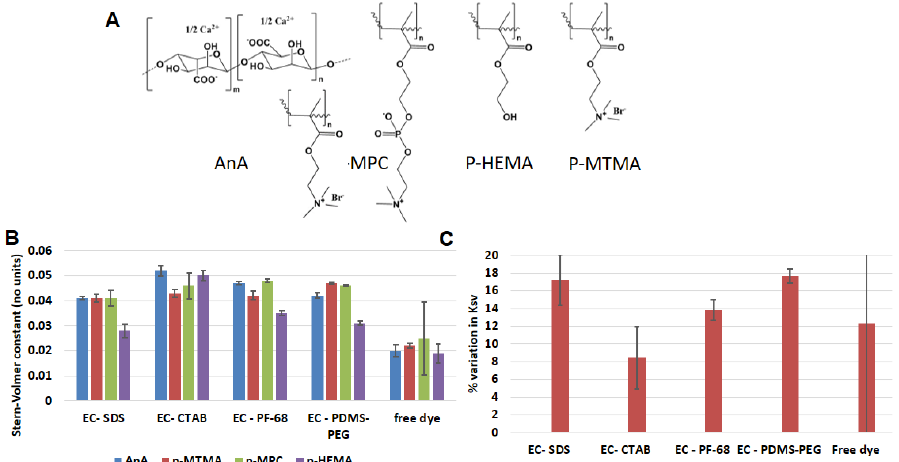
Figure 4. ( A ) Molecular structures of repeat units of calcium alginate (AnA), poly methacryloxyethyl phosphorylcholine (p ‐ MPC), poly hydroxyethylmethacrylate (p ‐ HEMA), and poly trimethylami ‐ noethyl methacrylate (p ‐ MTMA) ( B ) Ksv ( μ M − 1 ) values for different formulations of ethyl cellulose NPs in different matrix and ( C ) percentage variation in K sv between different hydrogel matrices for different ethyl cellulose NPs.